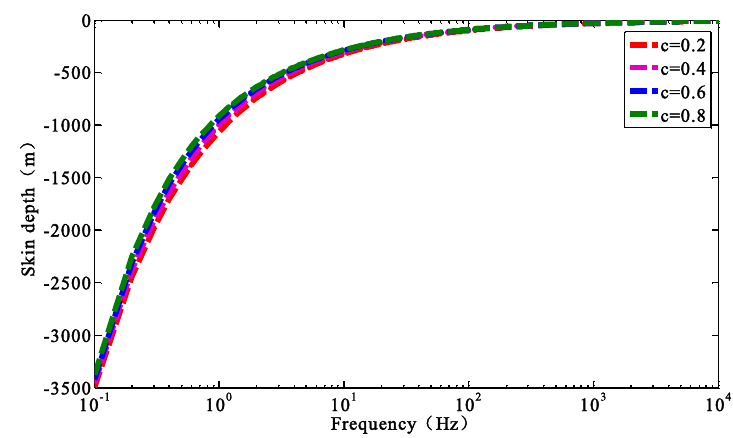
Figure 6. Generalized skin depth under different frequency dependence values.